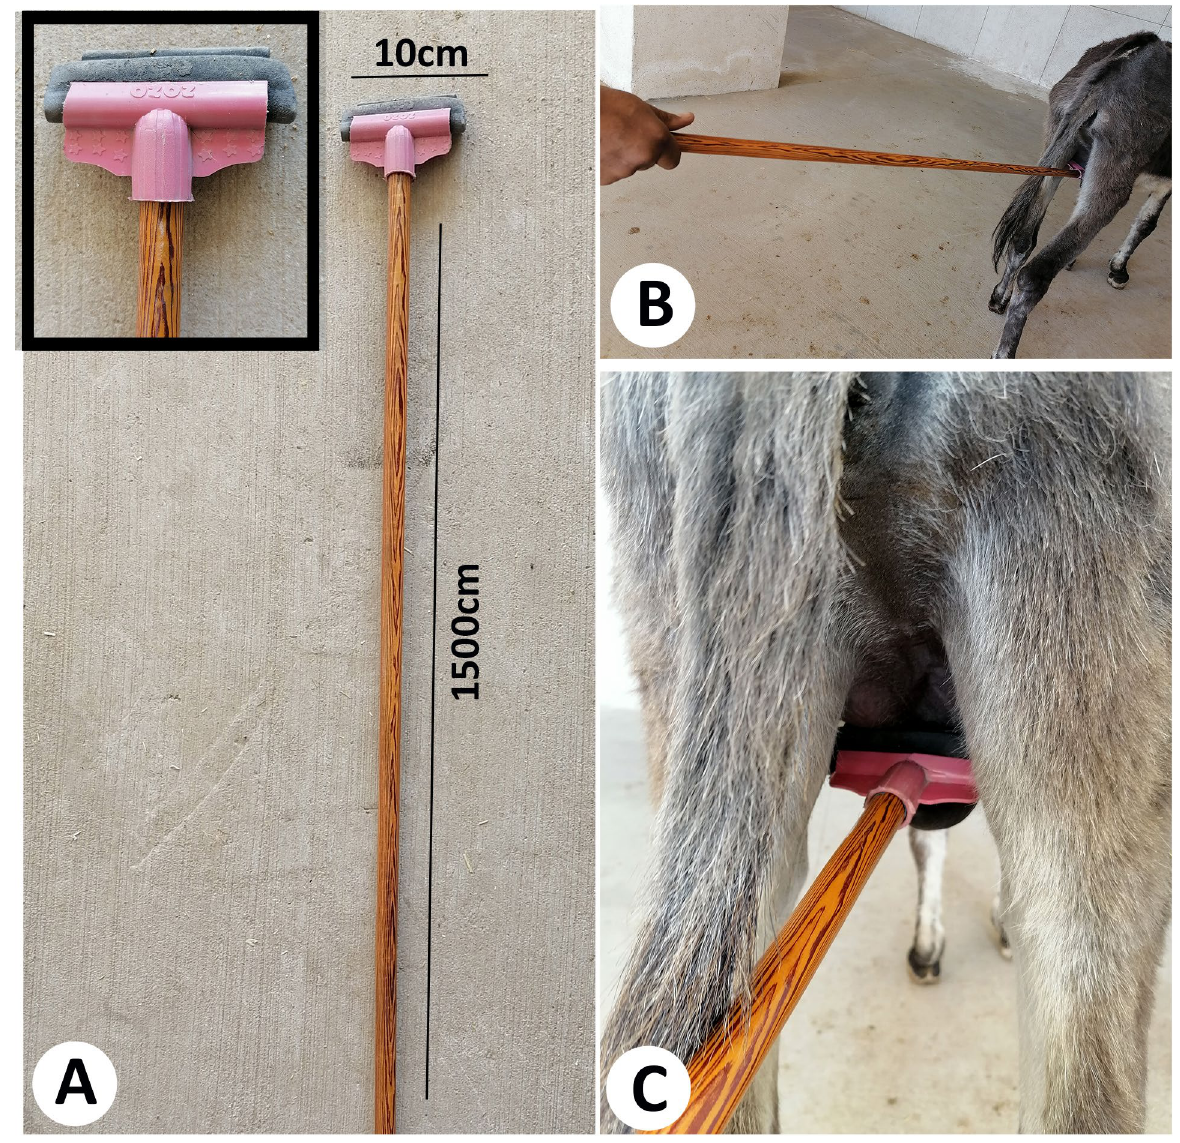
Figure 3. Application of mechanical pressure to the